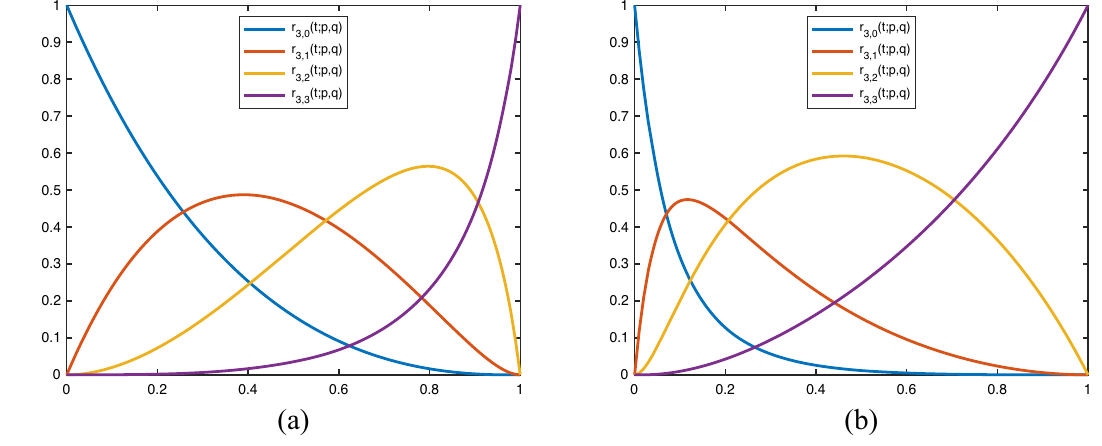
Figure 1: Weighted Lupa ş post - quantum cubic Bézier Bernstein blending functions. ( a )